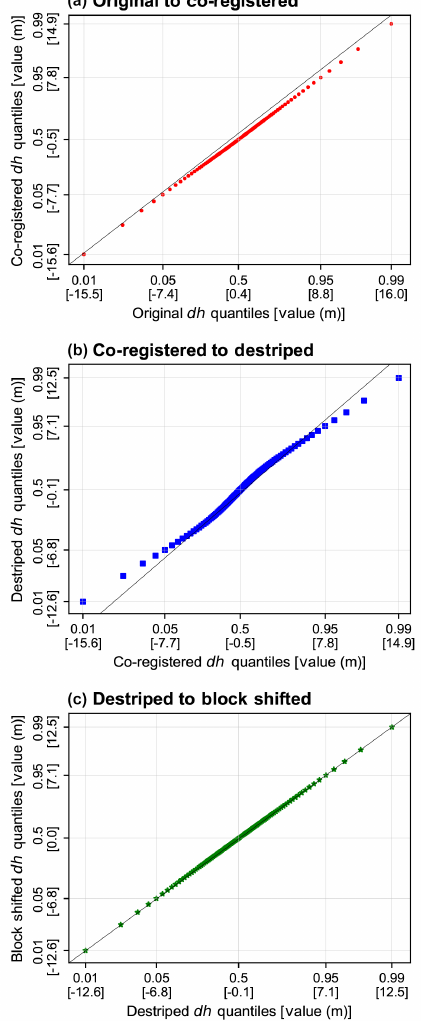
Figure 6. Quantile–quantile (QQ) plots showing the difference be- tween each successive correction step from three tiles merged and processed (24–26 ◦ S, 66 ◦ W). (a) Original to co-registered, (b) co- registered to destriped, and (c) destriped to block shifted. We note that co-registration and destriping have the greatest effect on zero- median shifting and narrowing the outliers. The quantiles (0.01, 0.05, 0.5, 0.95, and 0.99) and their respective values are indicated on each axis to highlight this